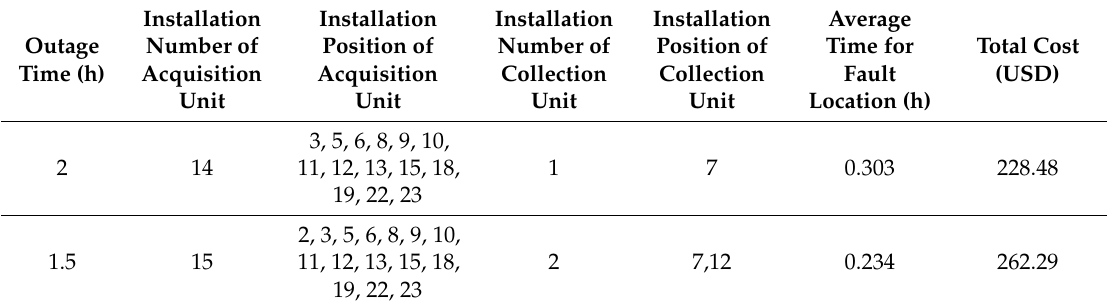
Table 3. Optional placement of fault indicators under di ff erent outage time of the system with fault.